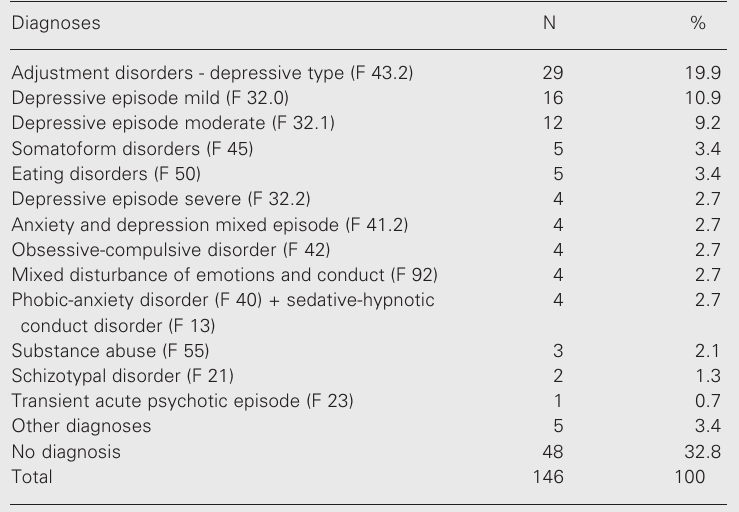
Table 1. The distribution of psychiatric diagnoses of graduate students at the Federal University of São Paulo (1996-2003).